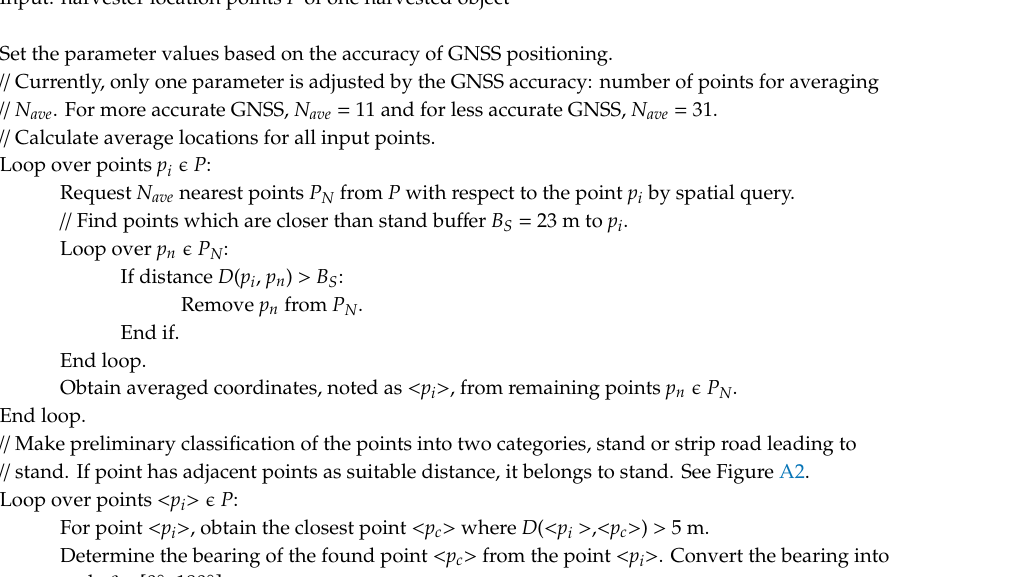
Algorithm A1 : Stand clustering and strip road